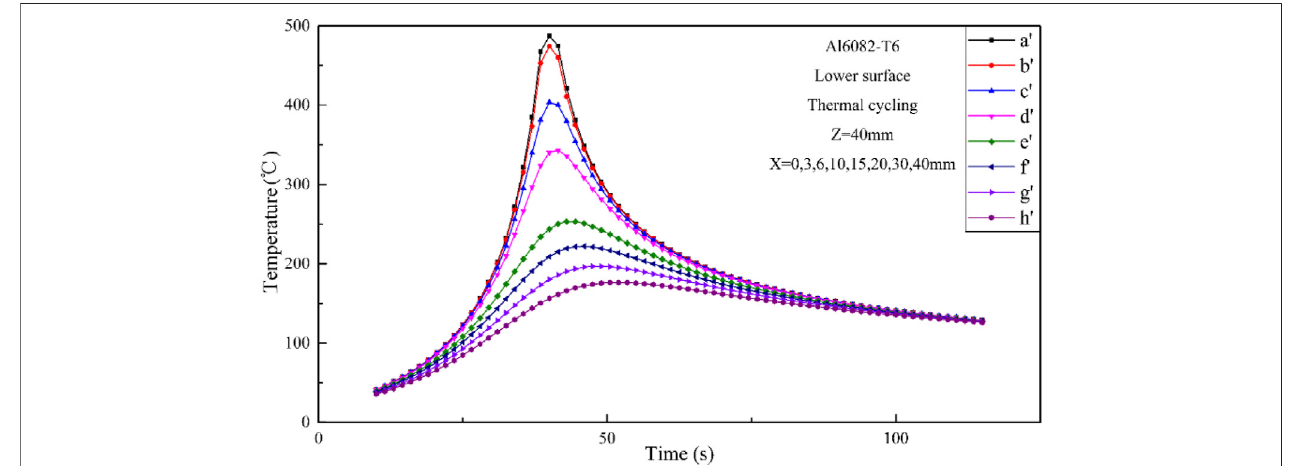
FIGURE 9 | Thermal cycle curves of feature points on the lower surface of the workpiece.